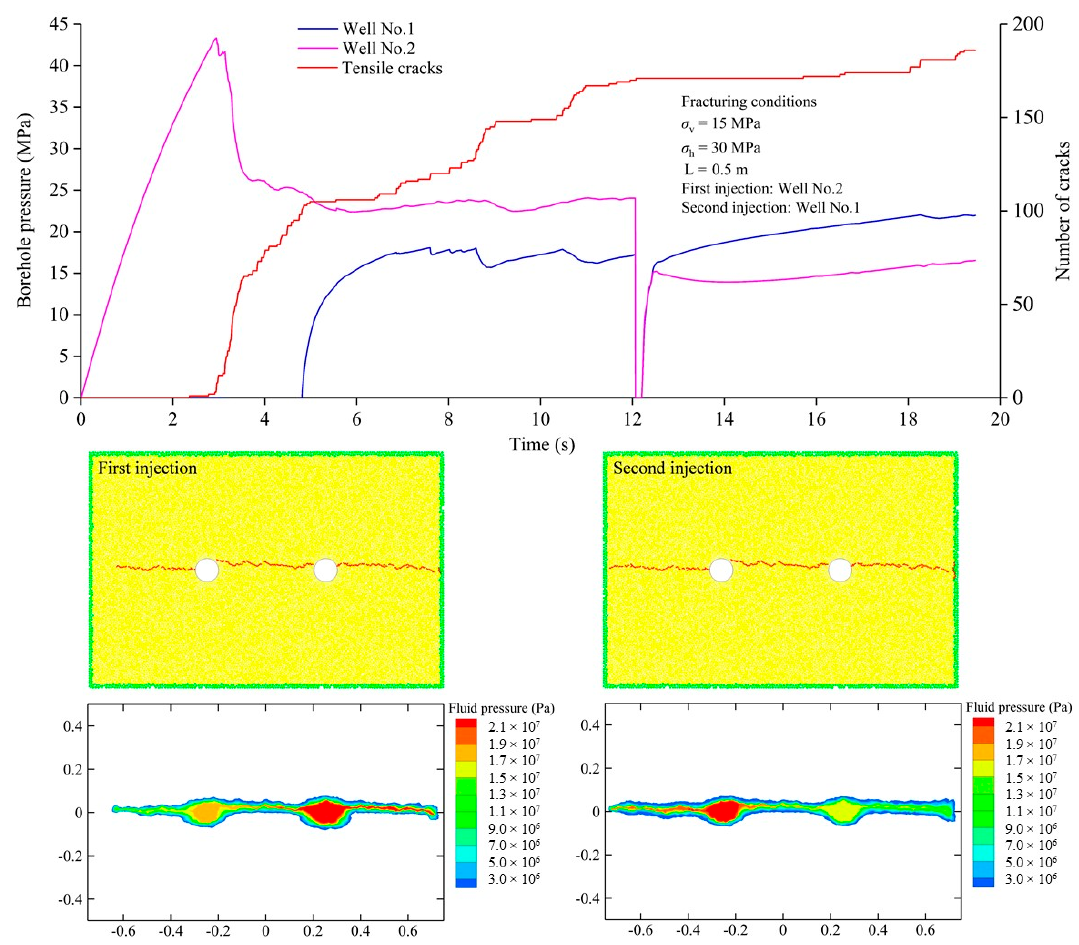
Figure 14. The borehole pressure histories, crack spatial distribution and corresponding fluid pressure field in the asynchronous fracturing (first injection: Well No.2 and second injection: Well No.1) under the in-situ differential stress condition ( σ v = 15 MPa and σ h = 30 MPa).